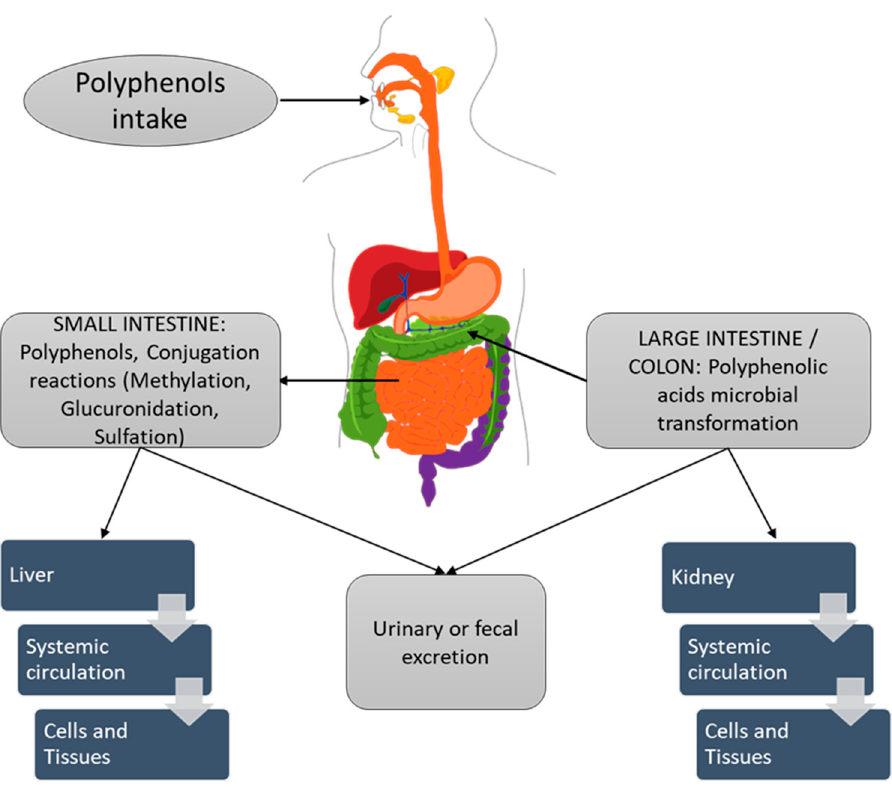
Figure 1. Schematic representation of polyphenol absorption after intake.